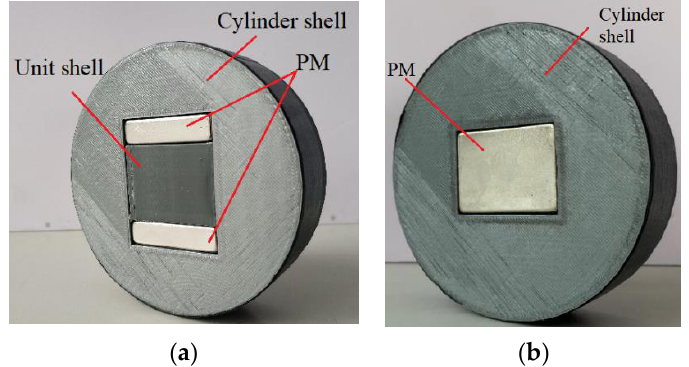
Figure 1. Configuration of two types of test samples. ( a ) Type A; ( b ) Type B.